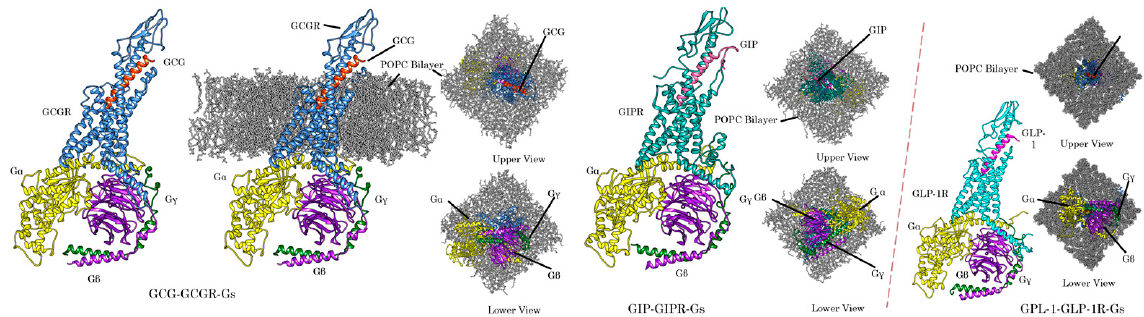
Figure 7. Computational design of endogenous agonist-bound GCG/GIP/GLP-1 receptors in com- plex with heterotrimeric Gs proteins, composed of G α , G β , and G γ